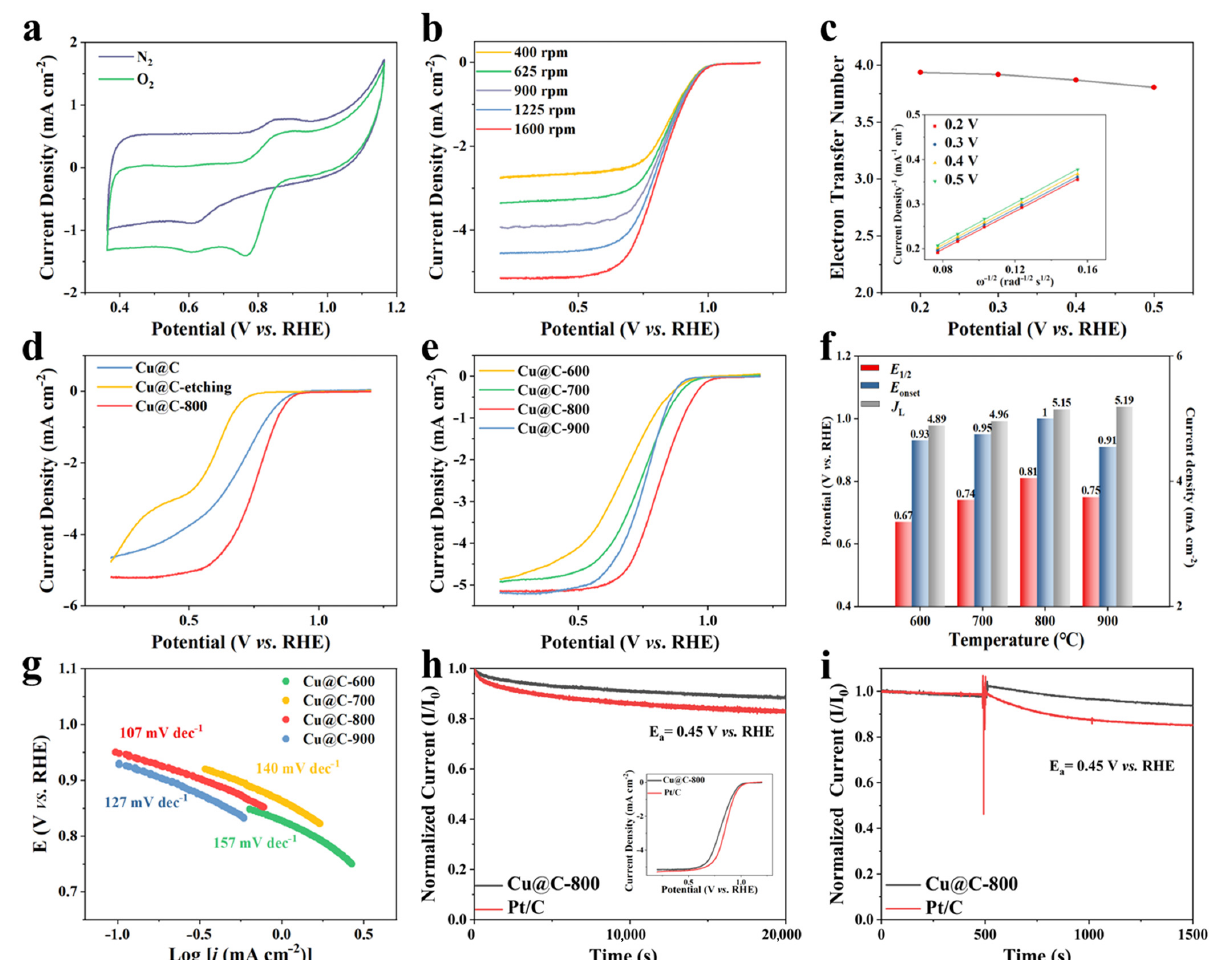
Figure 5. Cu@C-800 ( a ) CV, ( b ) LSV at different speeds, ( c ) electron transfer number 1600 rpm under O 2 saturation ( d ) LSV of Cu@C, Cu@C-etching, Cu@C-800 ( e ) LSV of Cu@C-(600, 700, 800 and 900) ( f ) Cu@C-(600, 700, 800 and 900) E onset , E 1/2 , JL. ( g ) The Tafel slope of Cu@C-(600, 700, 800 and 900); ( h ) stability test of Cu@C-800 and Pt/C and ( i ) methanol resistance test of Cu@C-800 and Pt/C.